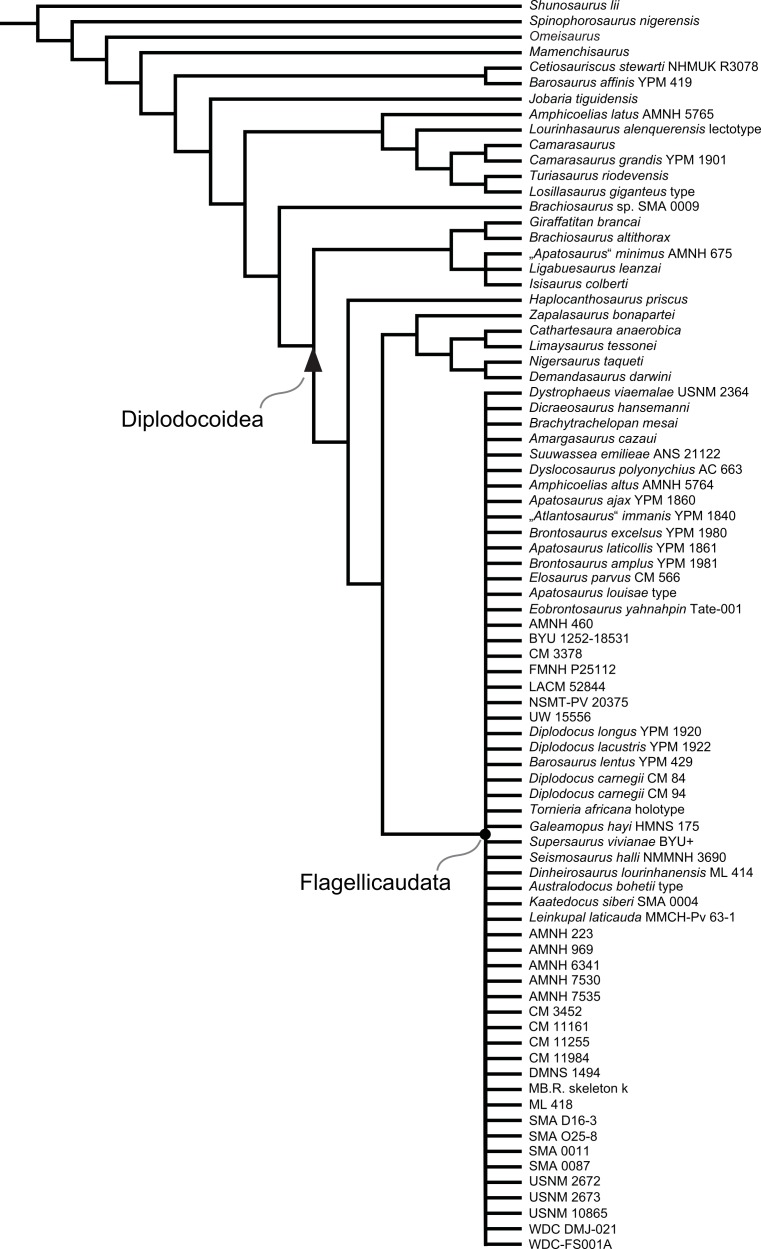
Strict consensus tree of the complete analysis with implied weighting.OTUs with species names and specimen numbers are type specimens. Tree length is 194.21603 steps. Note the basal position of Barosaurus affinis, Cetiosauriscus stewarti, the somphospondylian affinities of ‘Apatosaurus’ minimus, the diplodocine affinities of Australodocus bohetii, as well as the contrasting positions of Apatosaurus ajax YPM 1860 and FMNH P25112 when compared with the result under equal weights (in red).